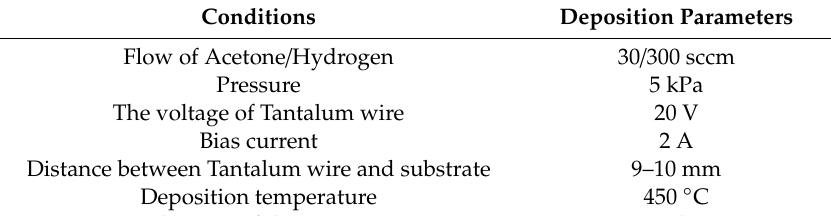
Table 1. Preparation conditions of CVD diamond film.